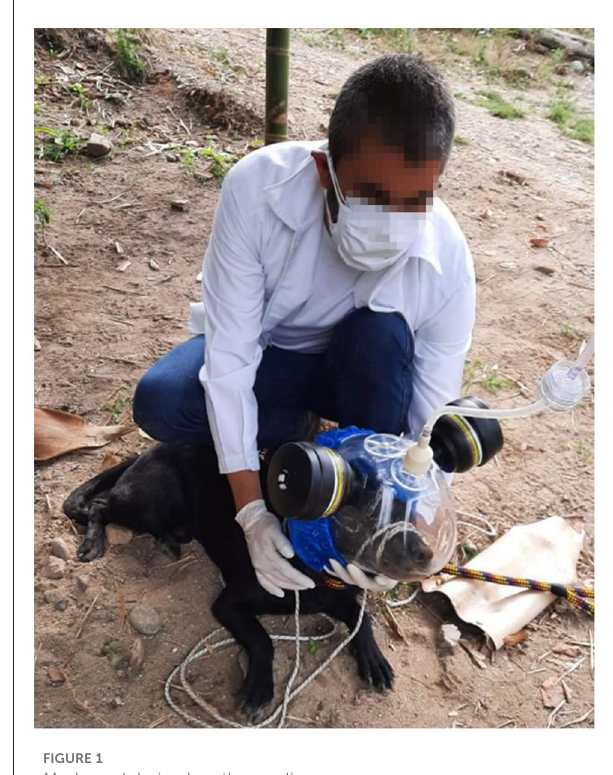
FIGURE1 Mask used during breath